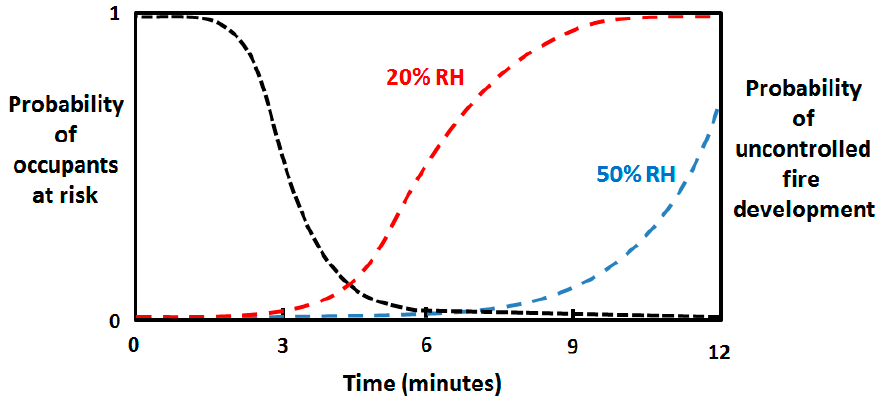
Figure 3. Sketch of people at risk ( - - - ) versus fire development in normal ( - - - 50% RH) and dry ( - - - 20% RH) conditions.